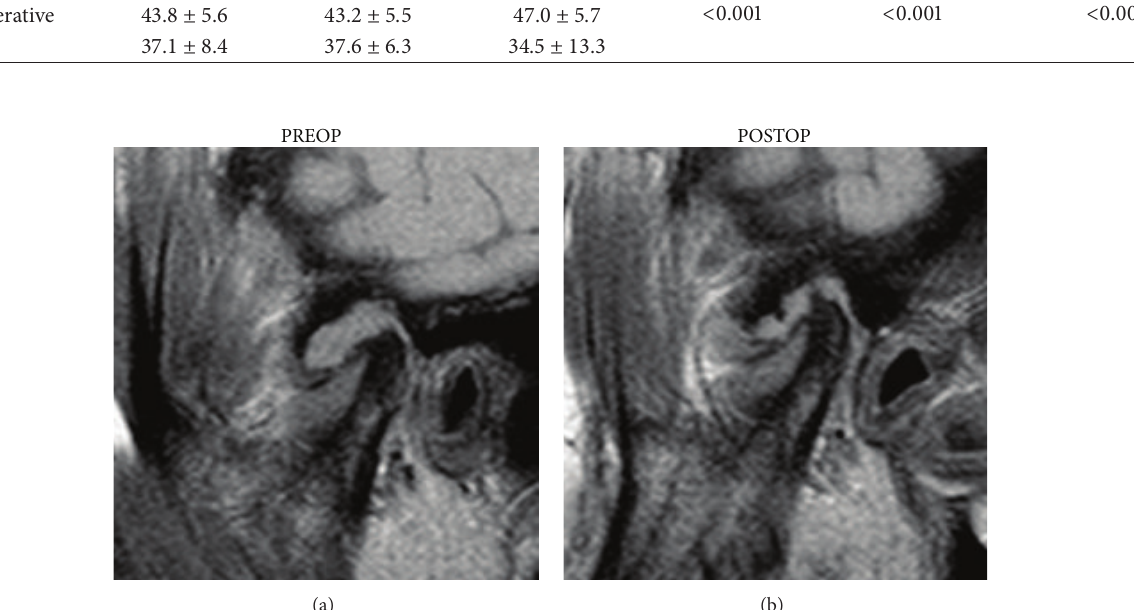
Figure 4: MRI: JE was identified as a high signal intensity area in the region of the joint space; note the mild reduction of inflammatory signs.